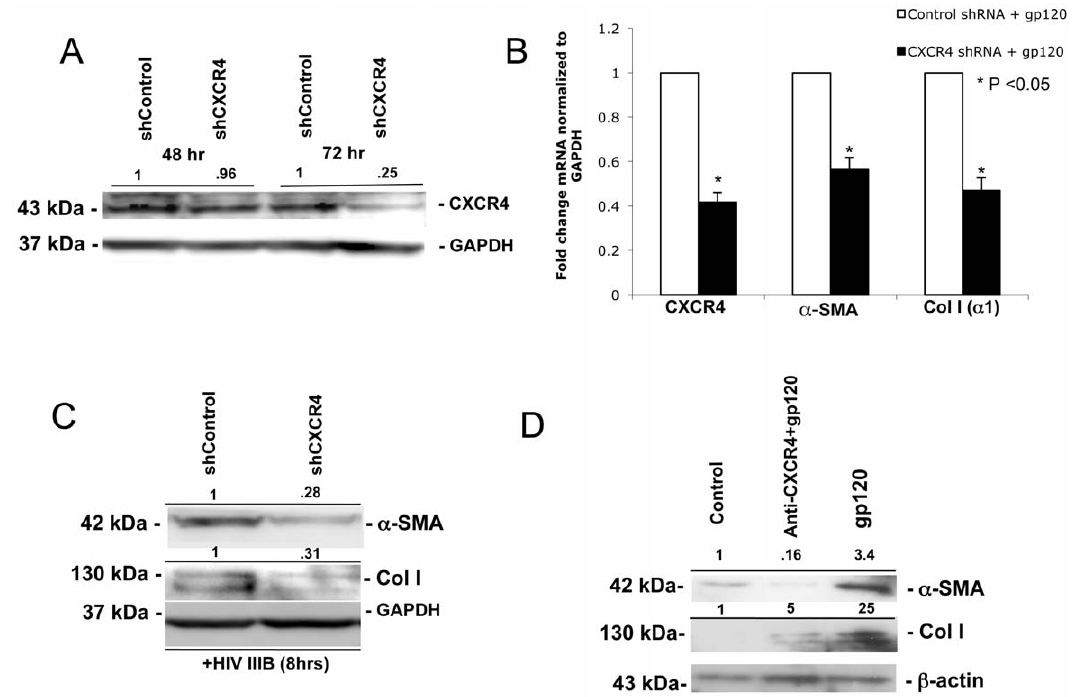
Figure 3. X4 gp120 induction of a-SMA and collagen I expression is CXCR4-dependent. (A) Passage # 3 primary HSCs were plated at a density of 2 6 10 4 cells/well in 6-well plates, serum-starved for 24 hours, and then transfected with shCXCR4 or shControl. A 75% reduction in CXCR4 protein expression was noted 72 hours after transfection by Western blot. (B) 72 hours after shControl or sh CXCR4 transfection, primary HSCs were then challenged with X4 gp120 for 2 hours, RNA harvested, reverse transcribed and qRT-PCR performed for CXCR4, a-SMA, and coll I (a1). A 40–50% reduction in gp120-induced collagen (a1) and a-SMA mRNA levels was observed with CXCR4 knockdown. Data are expressed as the mean 6 standard deviation of three independent experiments. (C) 72 hours after shCXCR4 knockdown, HSCs were challenged with HIV-IIIB for 8 hours and cell lysates used for Western blot where a 70% reduction in the protein expression of both a-SMA and collagen I was observed. (D) Human primary HSCs were pretreated with anti-CXCR4 antibody for 30 min (20 m g/ml) followed by treatment with gp120 (500 ng/mL) for 8 hours. Both X4 gp120-induced a- SMA and coll I protein expression were attenuated by anti-CXCR4 neutralizing antibody. ß-actin, a-tubulin, and GAPDH were used as loading controls. Representative Western blots with normalized densitometric arbitary units